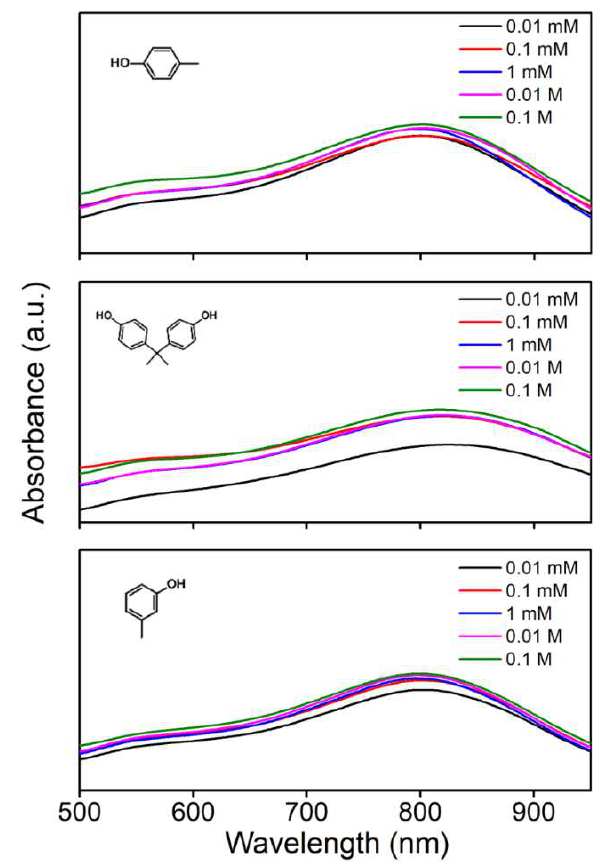
Figure 5. UV−vis absorption spectra of different concentrations of p -cresol-, bisphenol A-, and m -cresol-mediated reduction of Ag + on the Au NSs (from top to bottom).